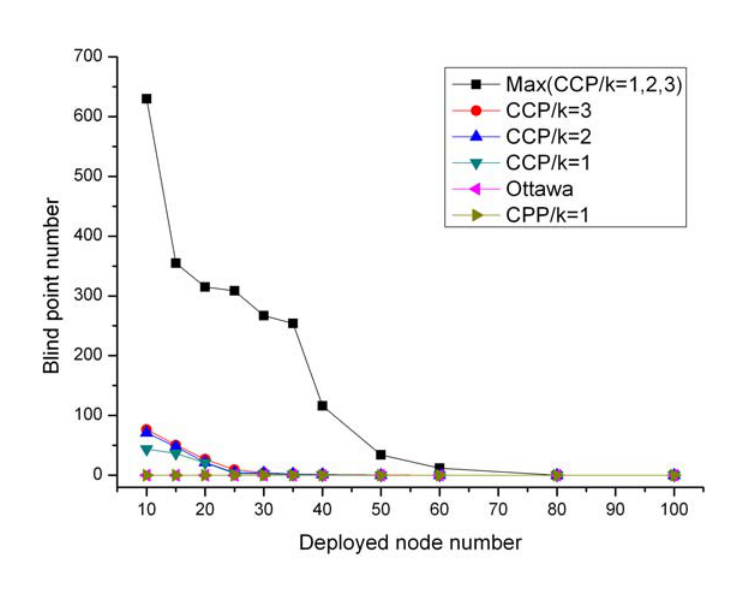
Figure 7. Blind points incurred by